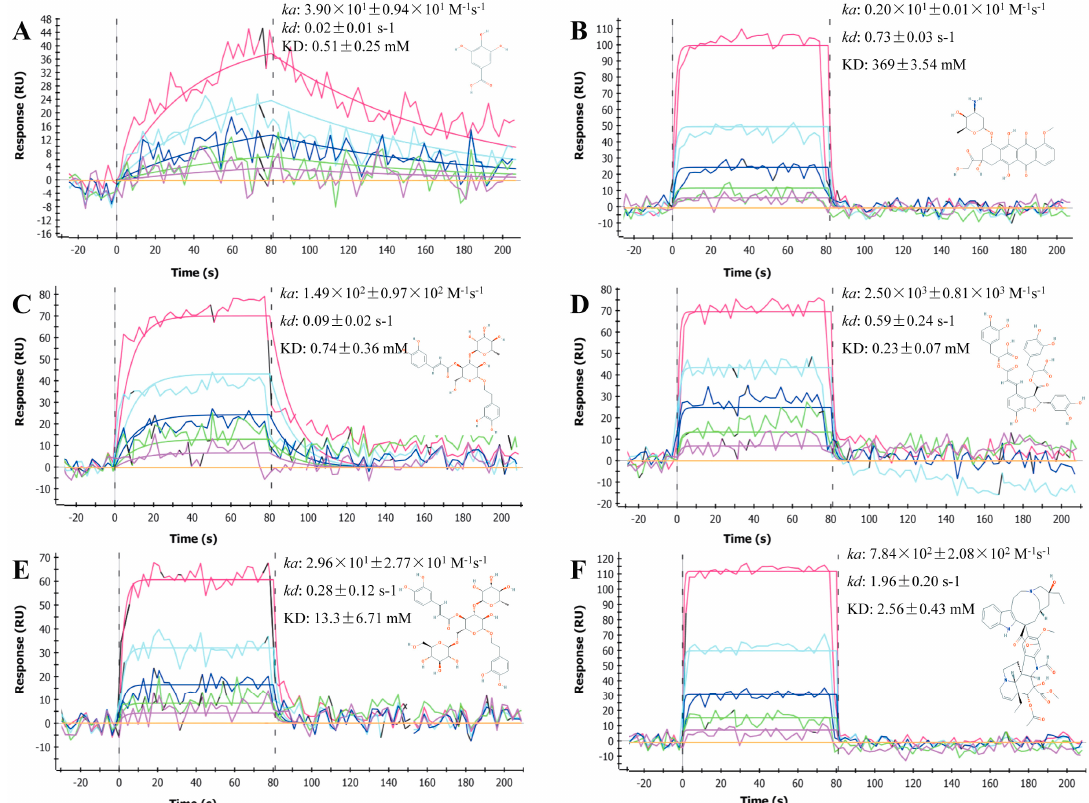
Figure 1. Sensorgrams for the interactions of BSA with the six test compounds; the structure of each compound was shown in the insets. Overlays of the models represented a global fit of the experimental data to a Langmuir 1:1 interaction model. Sensorgrams were representative of three independent experiments. ( A ) gallic acid; ( B ) doxorubicin; ( C ) acteoside; ( D ) salvianolic acid B; ( E ) echinacoside; and ( F ) vincristine.